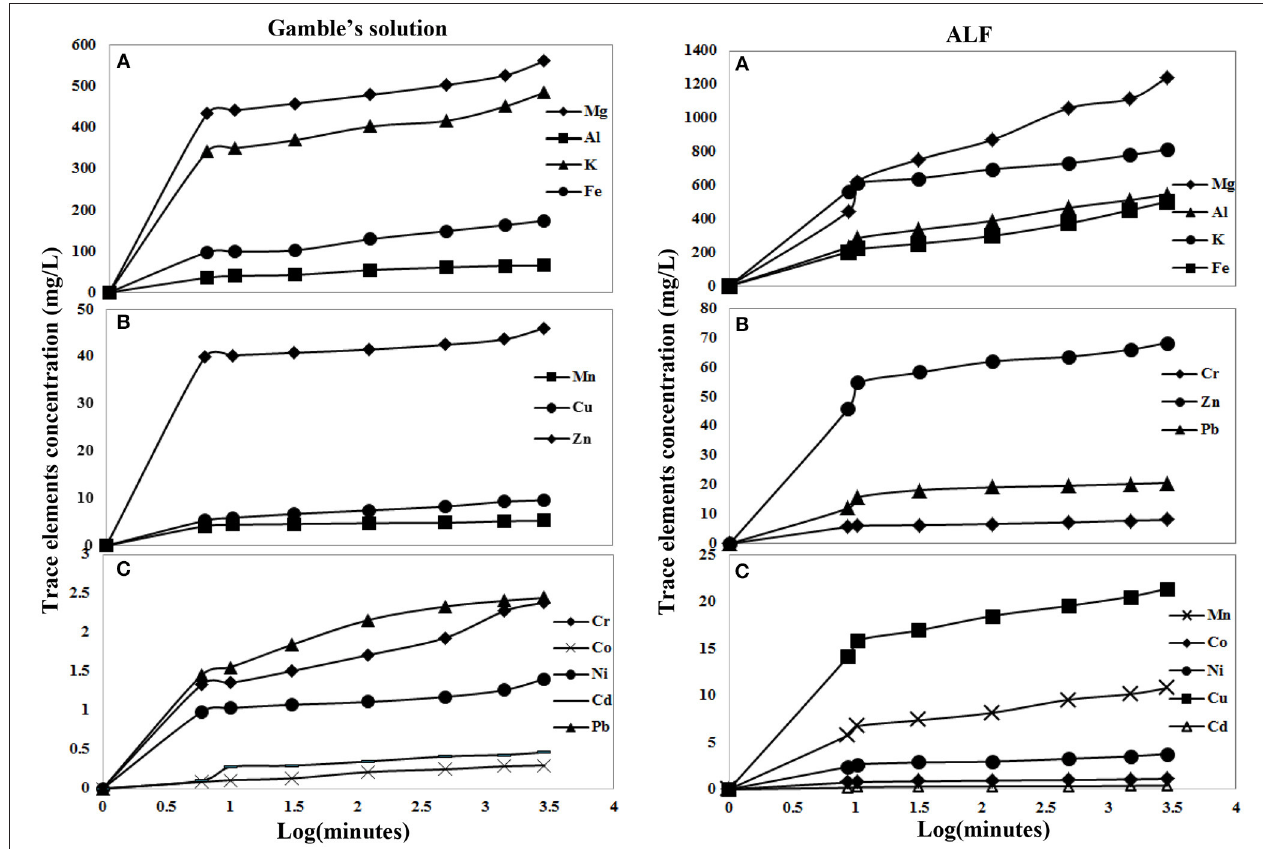
FIGURE 3 | Dissolution kinetics of different trace elements in the Gamble’s solution and ALF. Left: (A) for Mg, Al, K, Fe; (B) for Mn, Cu, Zn; and (C) for Cr, Co, Ni, Cd, Pb. Right: (A) for Mg, Al, K, Fe; (B) for Cr, Zn, Pb; and (C) for Mn, Co, Ni, Cu, Cd.